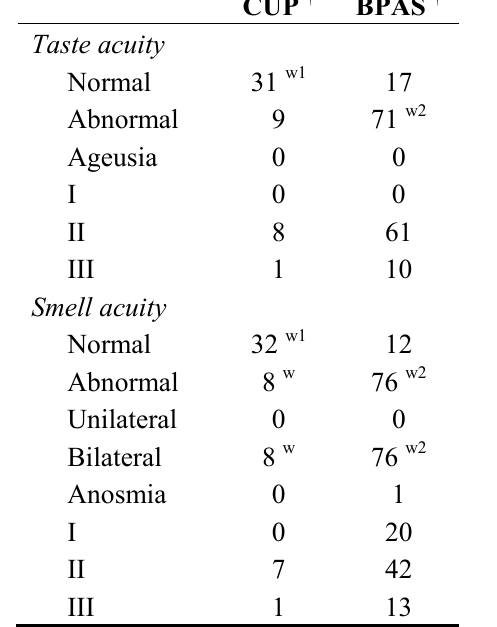
Table 5. Taste and smell acuity in patients with phantosmia. CUP † BPAS †